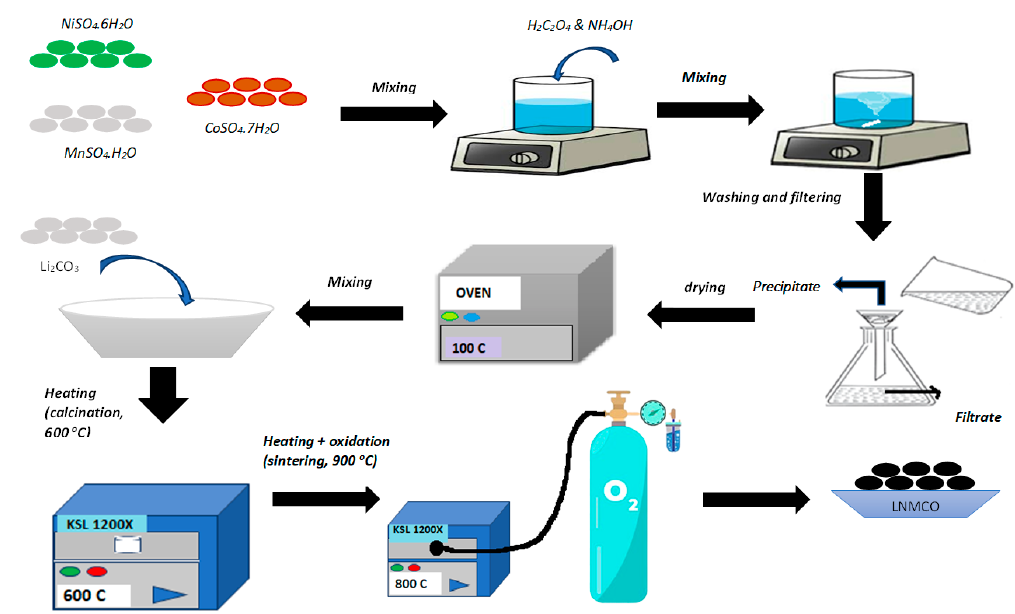
Figure 1. A schematic illustration of the NMC ‐ 811 cathode precursor synthesis. The synthesized NMC 811 cathode precursor of SM ‐ LNMCO ‐ 811 and SX ‐ LNMCO ‐